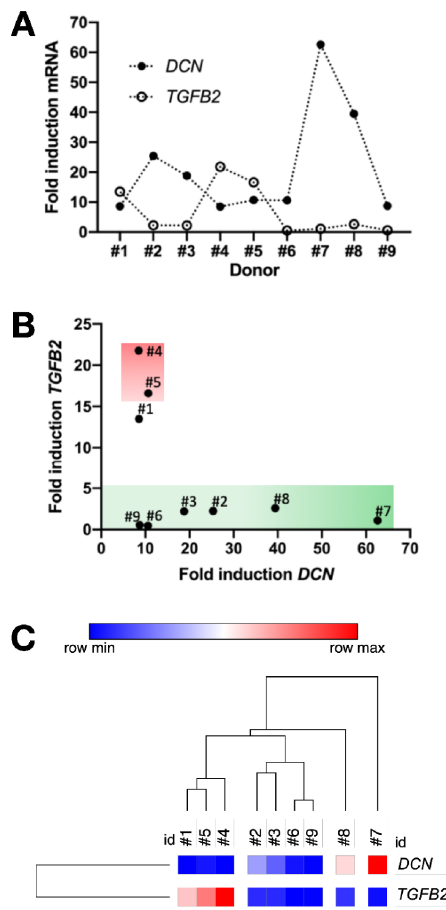
Figure 10. Prospective identification of osteogenic potency derived from ( A ) the inter-donor heterogeneity for fold-induction of gene expression for DCN and TGFB2 after one week of osteoinduction, tracing an inverse correlation expression pattern across the hMSC derived from donors #1 to #9, allowing ( B ) a correlative plot between these two genes discriminating non-bone-forming hMSC (red zone) versus bone-forming hMSC (green zone). ( C ) Dendrogram of Euclidian cluster analysis for all donors using gene induction data from DCN and TGFB2 .